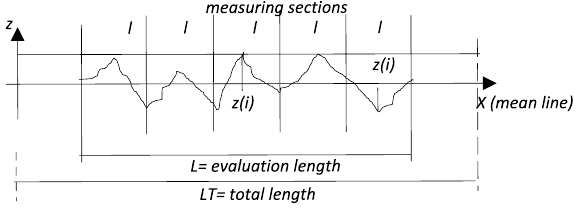
Fig. 4 Abbot curve of the roughness parameter Rmr (contact line) (%)